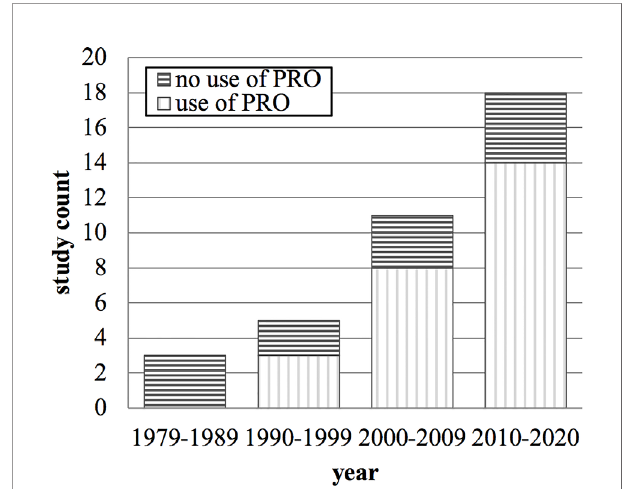
FIGURE 2 | Count of clinical studies stating a “ palliative effect ” of palliative radiotherapy for head and neck cancer and their use of patient-reported outcomes over time in years. PRO, patient-reported